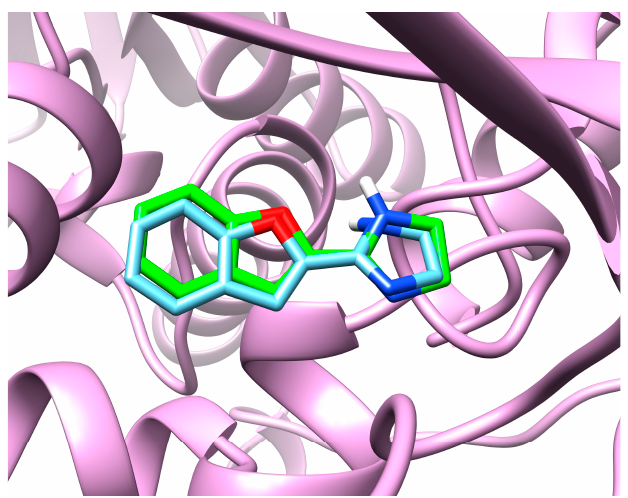
Figure 7. The image indicates the re-docked pose of the control molecule using Glide XP docking (cyan—co-crystallized pose, green—re-docked pose).